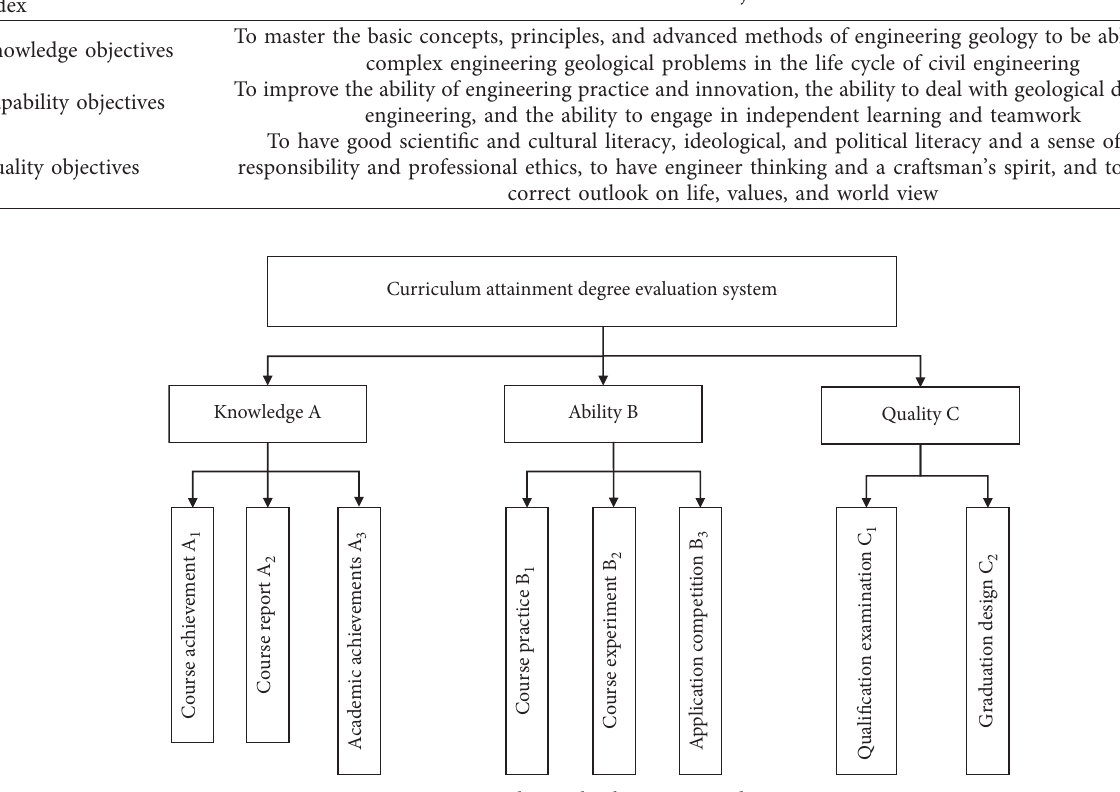
Figure 2: Curricular goal achievement index system.